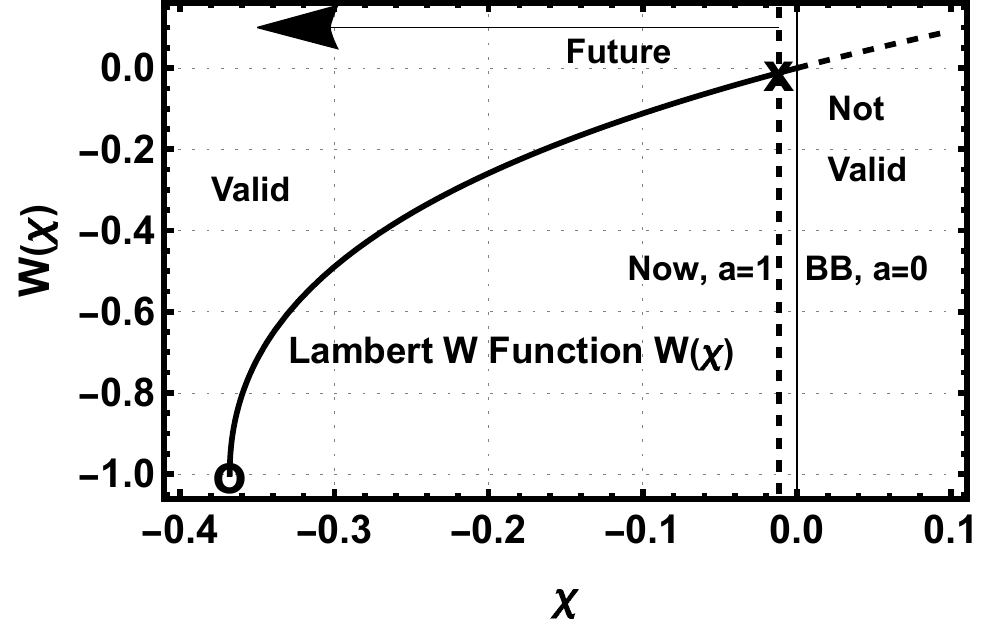
Figure 2. The figure shows the valid region with negative χ and invalid regions with positive χ of the W function for this work. The thin vertical line at χ = 0, a = 0, is the Big Bang. The χ on the track is the present day location, and the O at the end of the track is when the acceleration goes to zero. A more detailed description of the figure is given in the